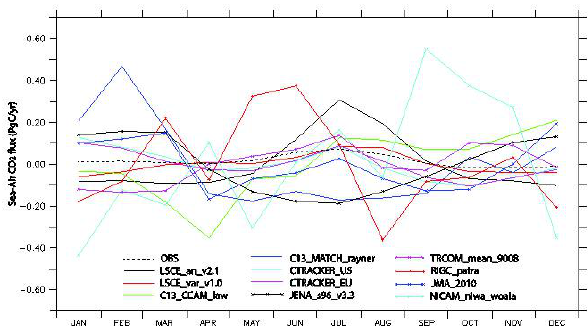
Fig. 10. The seasonal cycle of the sea–air CO 2 flux anomaly for the northern Indian Ocean (30 ◦ N–18 ◦ S) from atmospheric inversions; overlain on the plot (dashed line) is the observed seasonal